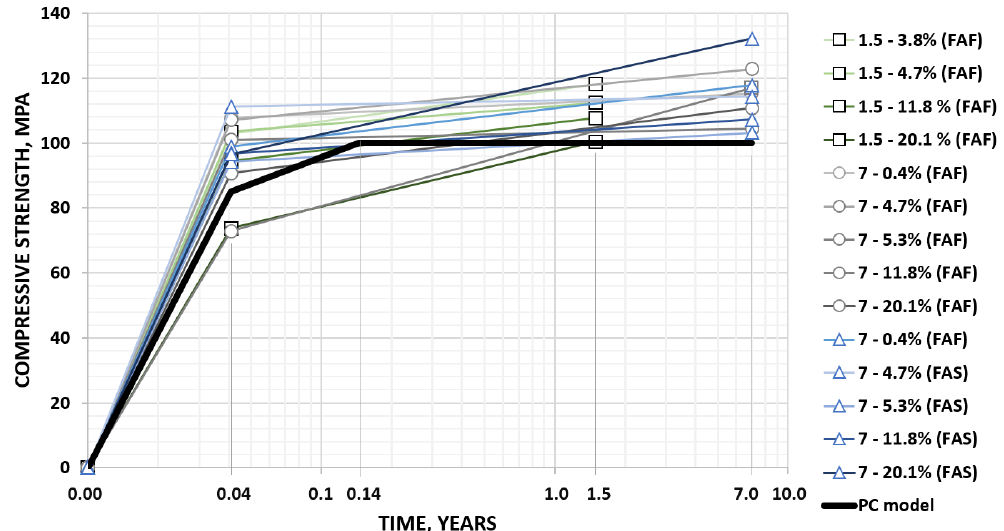
Figure 2. Development of the strength of polymer concretes with various mass contents (0.4–20.1%) of fly ash in a microfiller fraction in time; FA F , fly ash from fluidized bed combustion (FBC); FA S , siliceous fly ash from conventional combustion (chart based on data published by the author in [20]